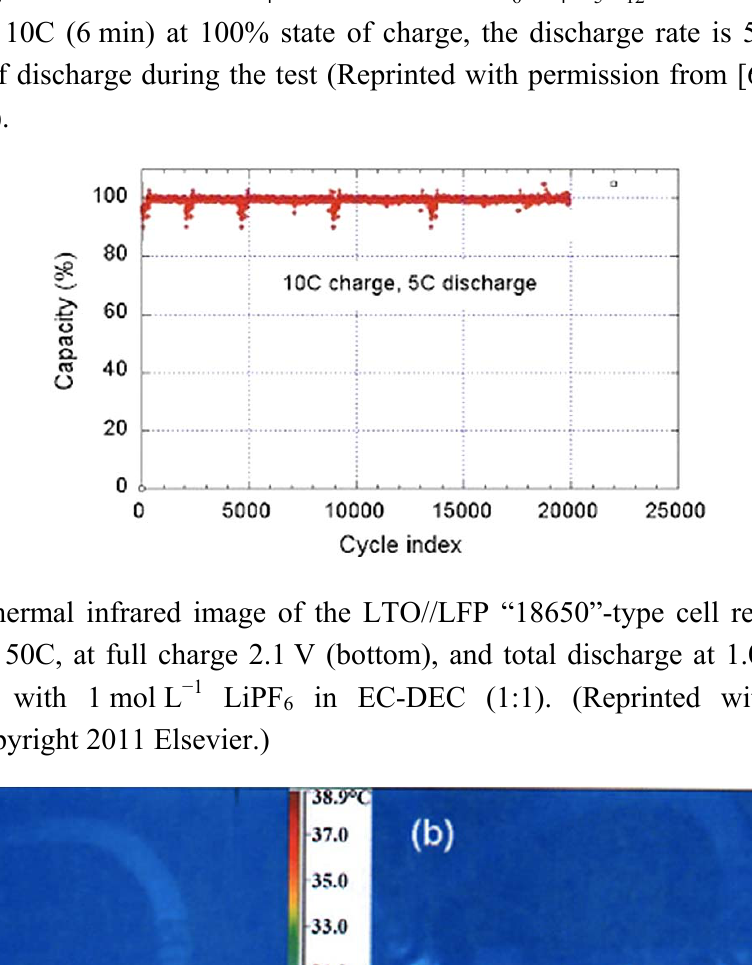
/EC-DEC-1 M LiPF /Li Ti O 18650-cell. The cycle 4 6 4 5 12